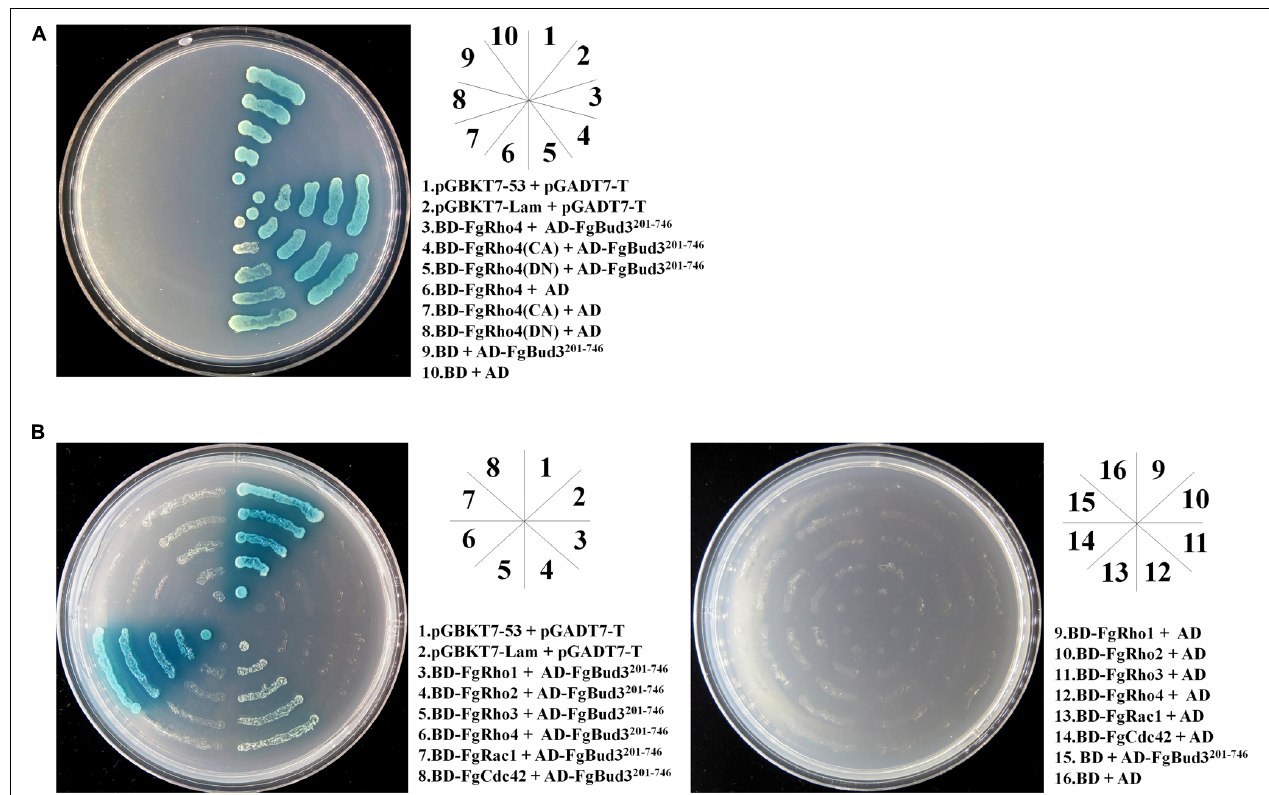
FIGURE 6 | FgBud3 interacts with FgRho4. (A) Yeast two-hybrid assay with FgRho4 (3) or FgRho4-CA (4) or FgRho4-DN (5) as the bait and FgBud3 201 − 746 (3–5) as the prey. (B) Yeast two-hybrid assay with each FgRho GTPase (3–8) as the bait and FgBud3 201 − 746 (3–8) as the prey. Twenty microliter yeast cells (10 7 cell/mL)